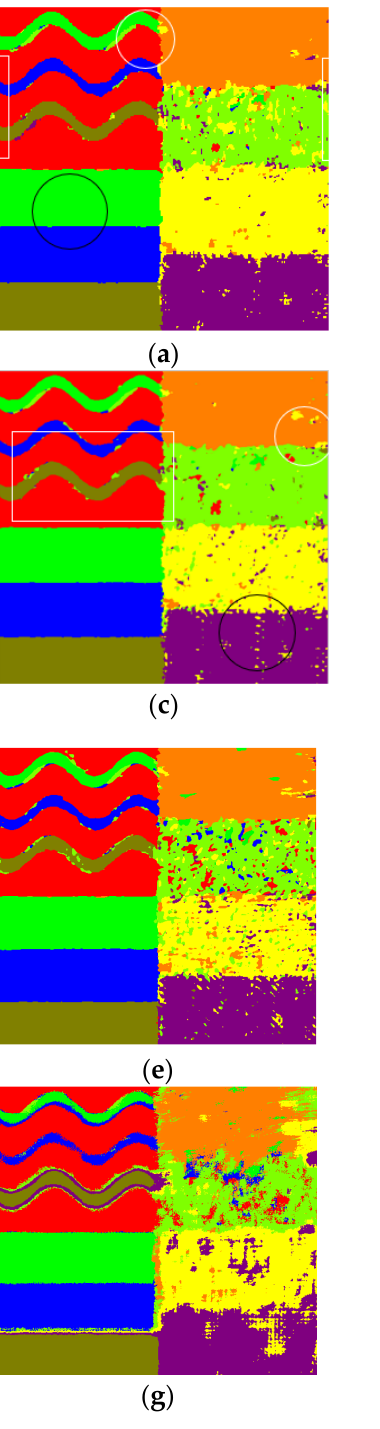
Figure 8. The classification result maps on the synthetic SAR image: ( a ) The results of the GCA- CNN; ( b ) The classification results of the SI-CNN; ( c ) The results of the OI-CNN; ( d ) The results of GHFM-CNN; ( e ) The results of the DBN; ( f ) The results of the SAE; ( g ) The results of the SVM. Table 1. Classification results on synthetic SAR image.